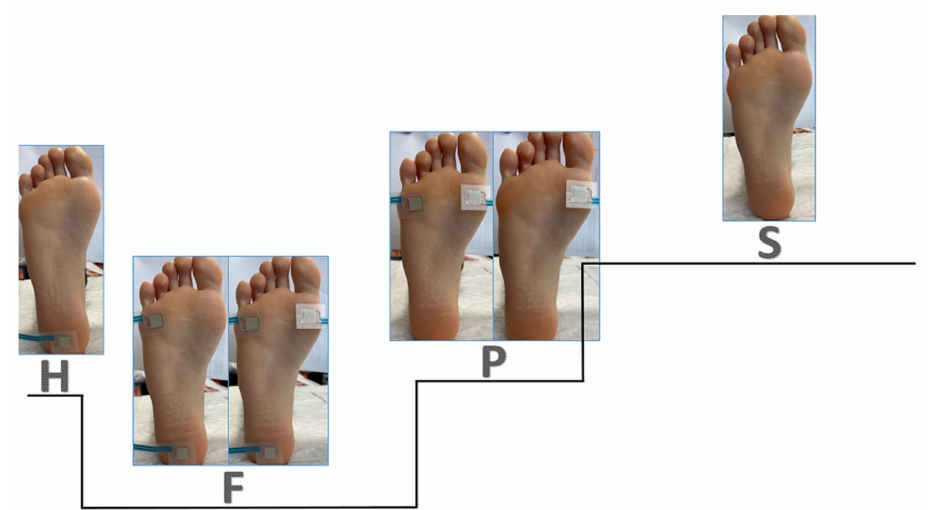
Figure 3. Gait cycle. H: heel contact, F: foot contact, P: push off, S: swing.